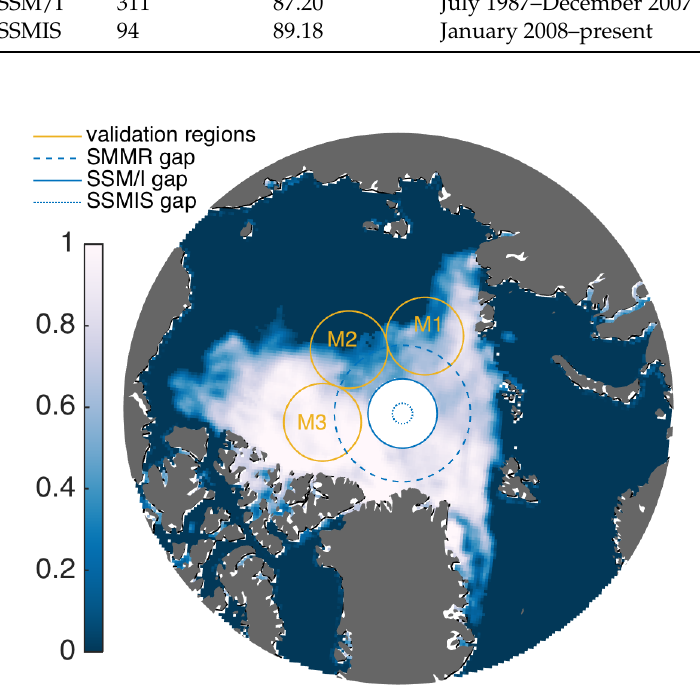
Figure 1. Yellow outlines indicate the three circular regions used to estimate the parameters of the stochastic term. These three circular regions were also used to validate and assess performance of the solution to Laplace’s equation. Blue circles show polar data gap extent for the three sensors indicated in the legend (see also Table 1). Shading indicates sea ice concentrations for 3 September